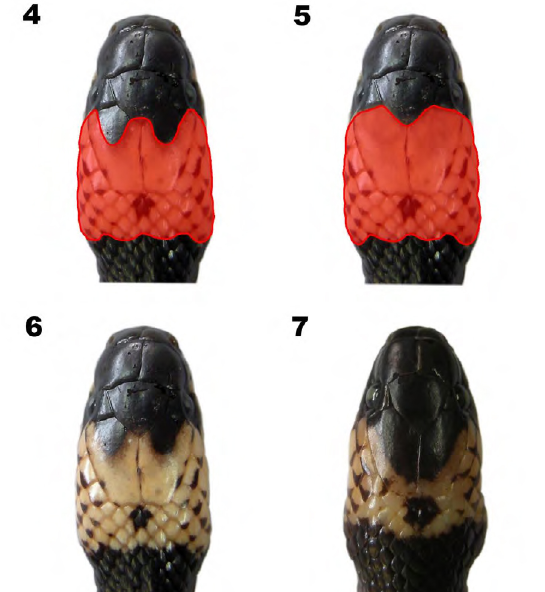
Figure 4–7. Patterns of nuchal collar form present in Trans-Andean popu- lations of Ninia atrata . Schematic representation of ( 4 ) W-shaped and ( 5 ) continuous pattern of nuchal coloration reported by Angarita-Sierra (2009). ( 6 ) W-shaped pattern (UIS-R – 2702) and ( 7 ) unusual U-shaped variation (UIS-R – 2703) of nuchal coloration found in specimens from Sierra Nevada de Santa Marta. Photos by F. Leonardo